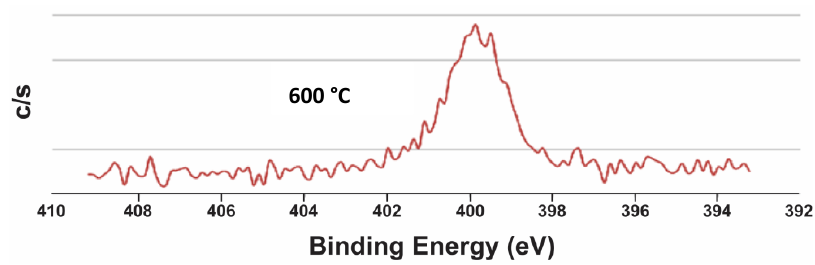
Figure 3. XPS spectrum of N 1s within C, F, N, B-codoped-TiO 2 sample.